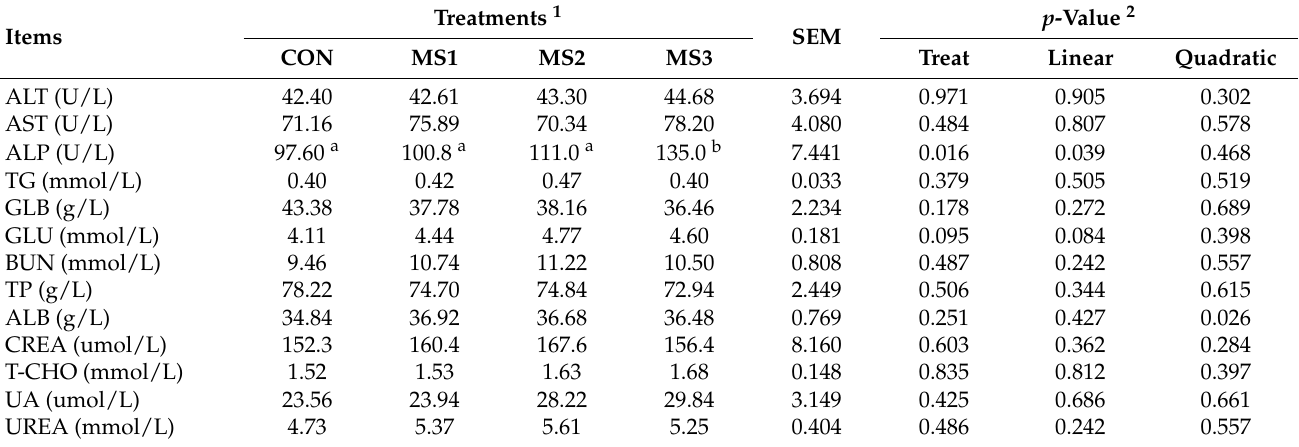
Table 4. Effect of MetaSmart supplementation in diets on serum biochemical indexes of